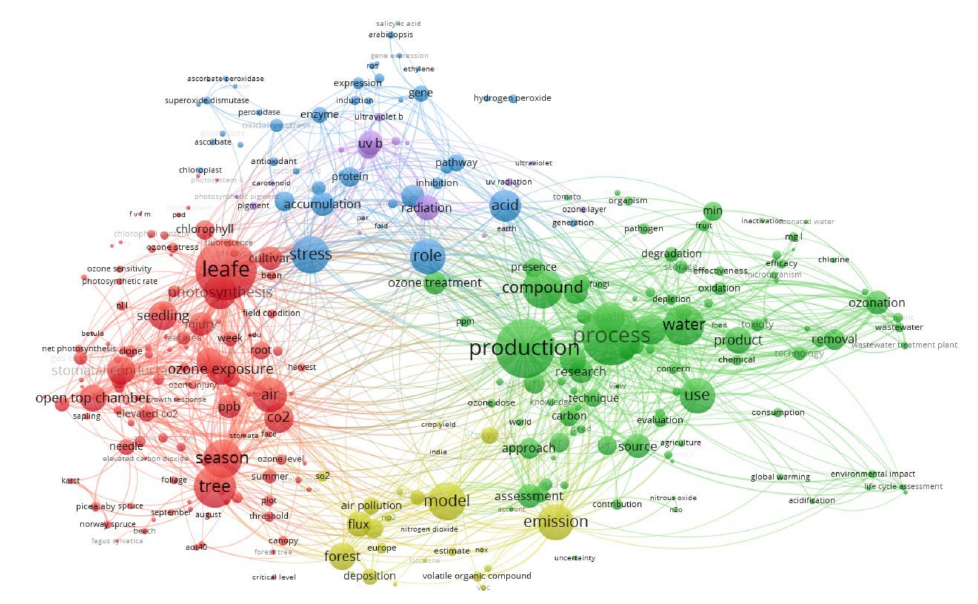
Figure 6. Word clouds based on worldwide research on ozone in the plant field. Terms named more than 100 times in titles and abstracts. The size of the circle under the word indicates the frequency of word occurrence. The five clusters, made by the VOSviewer program according to the relationship between the items, are represented in different